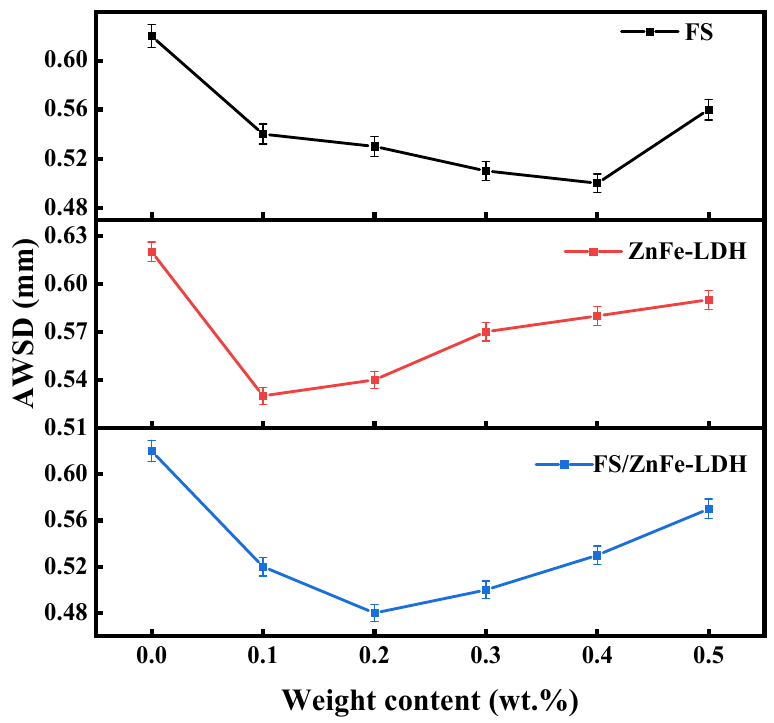
Figure 8. Trend of average wear scar diameter.